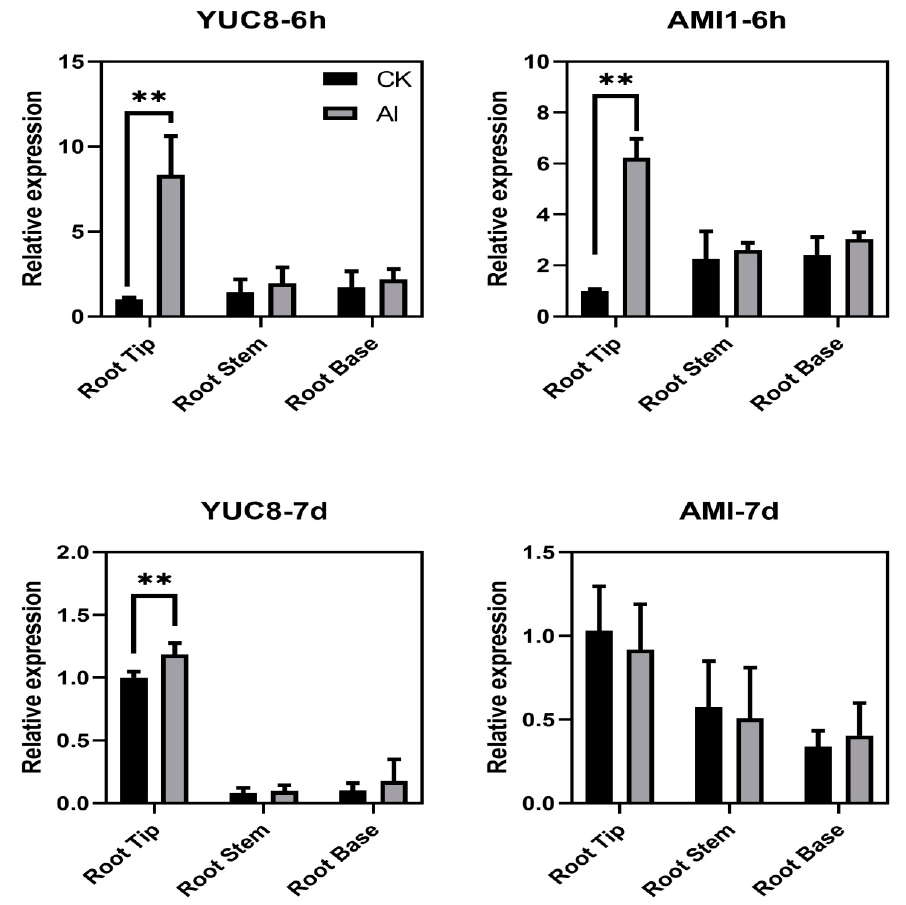
Figure 4. Changes in YUC8 and AMI1 expression in tea roots with and without Al treatment after incubation for 6 h and 7 d (** indicates significance at 0.01 probability level).